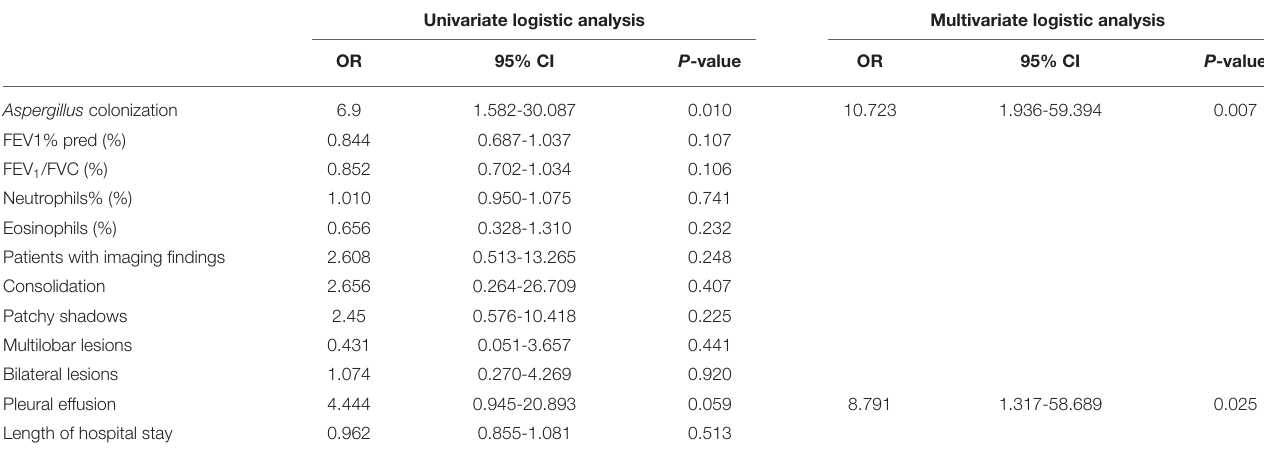
TABLE 6 | Univariate and multivariate logistic analysis for relapse of acute exacerbation in COPD patients within 180 days after discharge. Univariate logistic